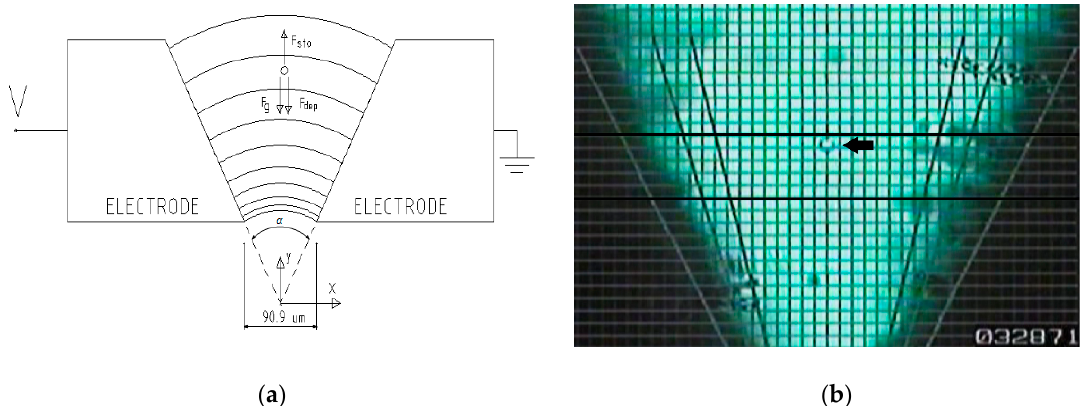
Figure 1. ( a ) Chamber and dynamic model diagram. Afterwards, α is defined as the angle between electrodes and β the angle between the electrode and the X -axis. Both are referred to in this figure. ( b ) Experiment frame. You can see one single measured cell (arrow) and the pearl chains following the electric field lines. The two thickest parallel lines where the measurements were made are in the lower right corner the frame counter.